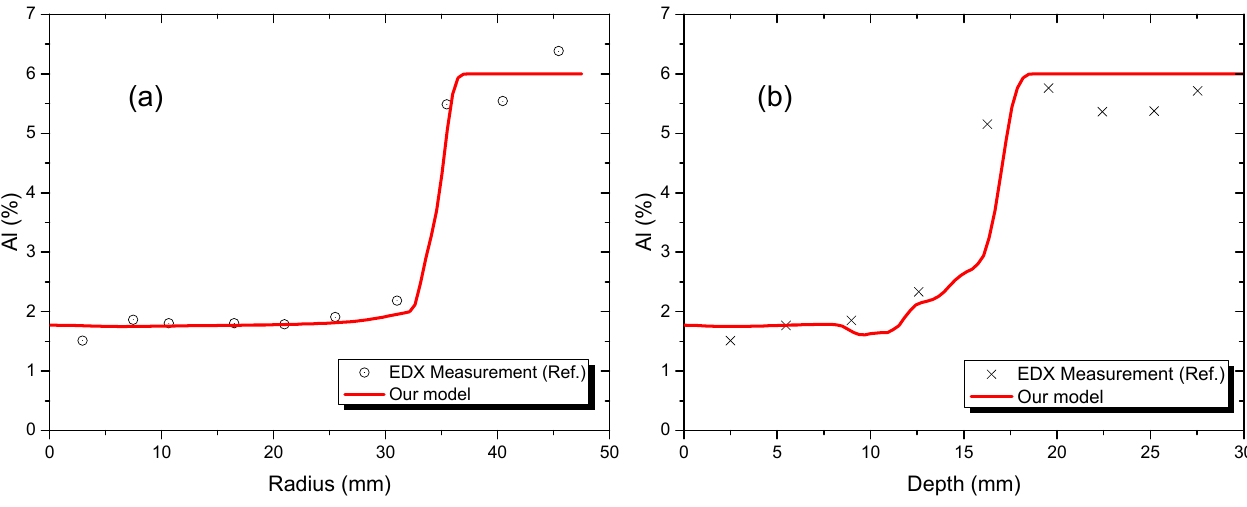
Figure 7. Comparison of predicted and measured Al concentration profiles in the EBBM sample. ( a ) Radius direction, ( b ) depth direction.